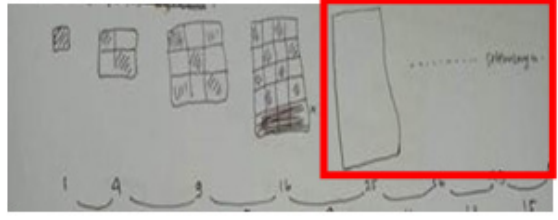
Figure 3. The Mathematics Anxiety In- lem